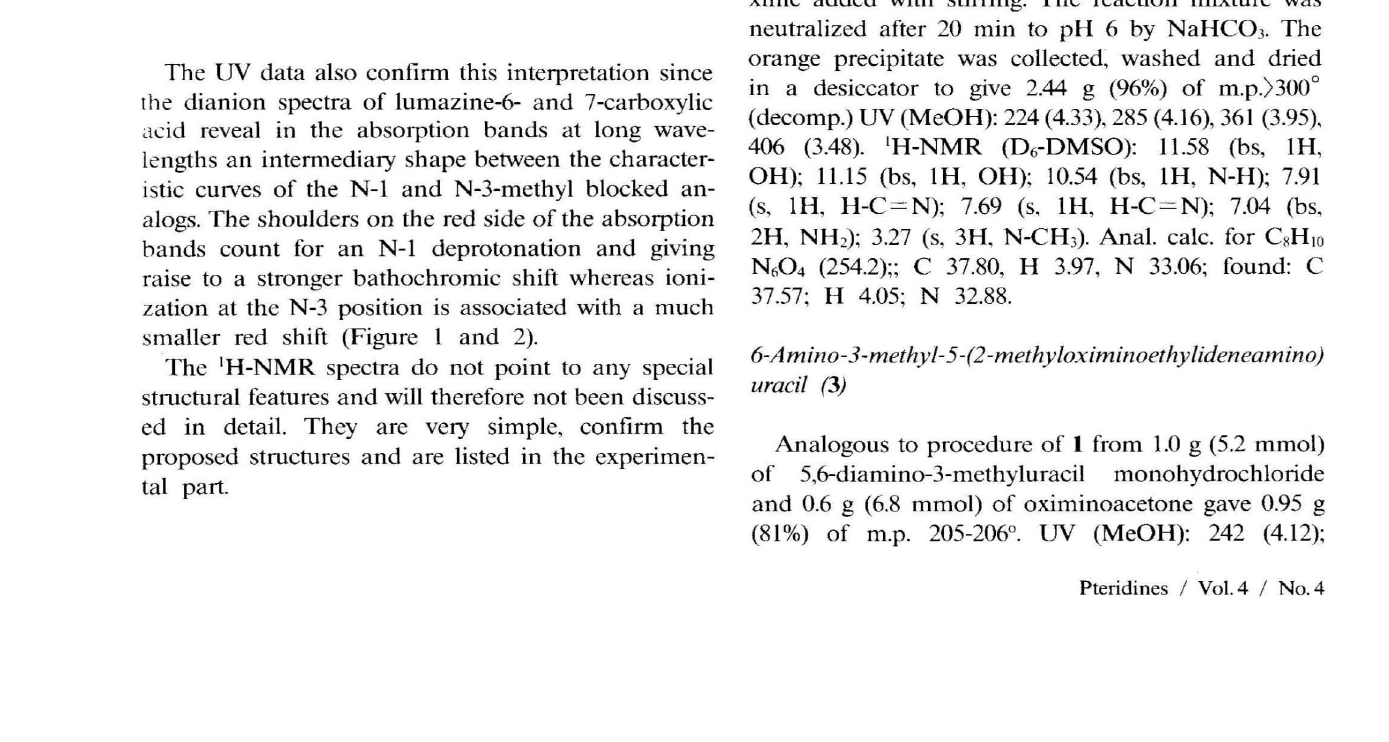
figure 2. UV Spectra of the dianions of lumazine-7-carboxylic ,-:id (23) (- . - . -) and its 1-(26)-(- --) and 3-methyl j~rivative (28) ( ......... ) at pH